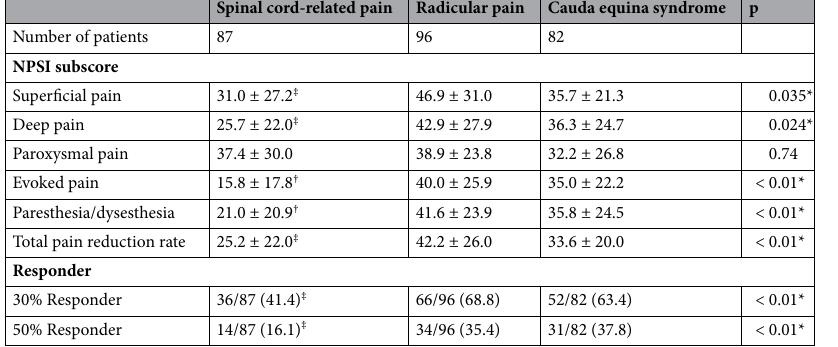
Table 3. NPSI subscores and response rates in patients with spinal cord-related pain, radicular pain, and cauda equina syndrome. Data are shown as mean ± SD. NPSI Neuropathic Pain Symptom Inventory. *Significant differences among groups. † p<0.05, compared to patients with radicular pain and cauda equina syndrome. ‡ p<0.05, compared to patients with radicular pain.